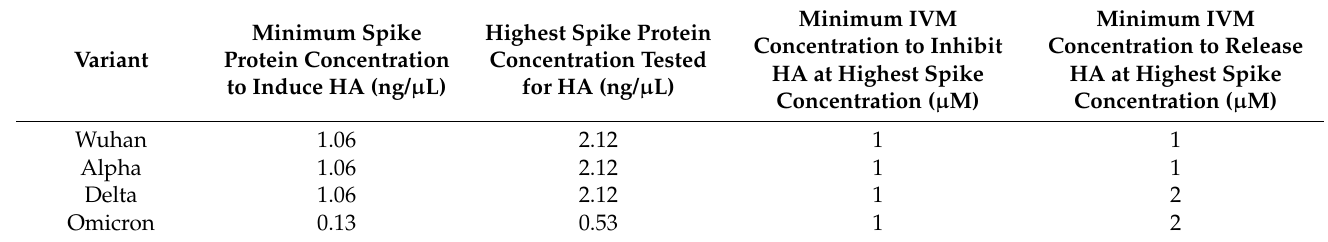
Table 1. Minimum concentrations of recombinant spike protein (ng/µL) needed to induce HA when added to RBC solution, and concentrations of IVM (µM) needed to inhibit or reverse this induced HA. Tests to determine these values were each done in triplicate.